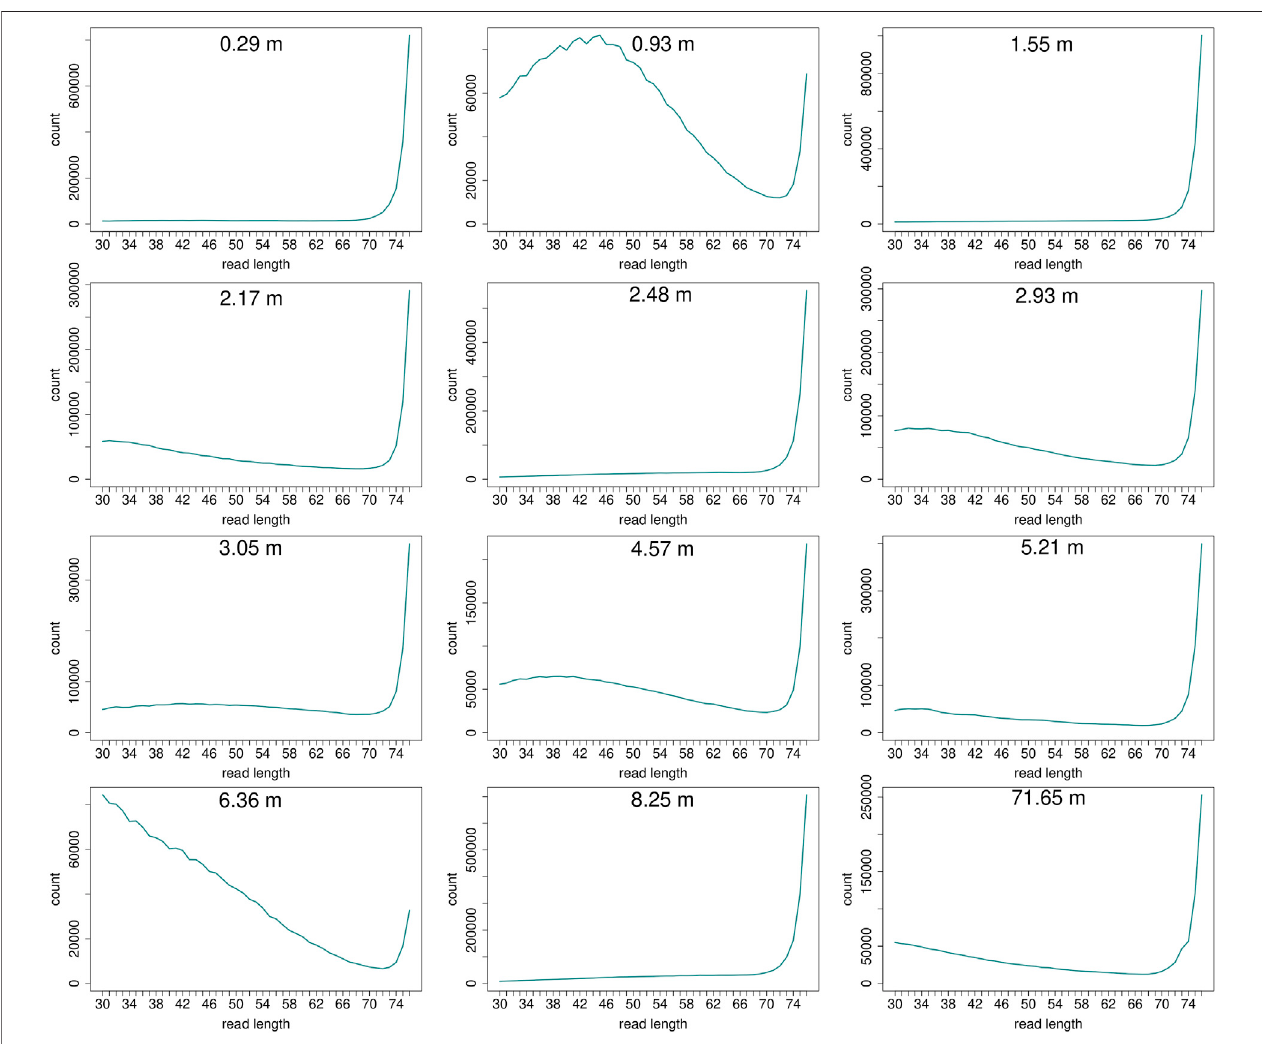
FIGURE 2 | Read length distribution of all reads after duplicate removal for fi rst round capture data. Samples at 0.93 m and at 6.36 m depth display a larger proportion of shorter reads in relation to the maximum possible length of 76 bp. However, this effect is less pronounced when taking into account the high fl uctuation of absolute read numbers on the y-axis. The curve of samples that have much fewer short reads in relation tolonger reads ( > 70 bp) may appear fl at, but the counts usually stillrangeinthetensofthousands(0.29 m:at30 bp13,023readscounted,at70 bp23,980;1.55 m:at30 bp11,802,at70 bp28,943;2.48 m:at30 bp6,855,at 70 bp 25,867; 8.25 m: at 30 bp 7,997, at 70 bp